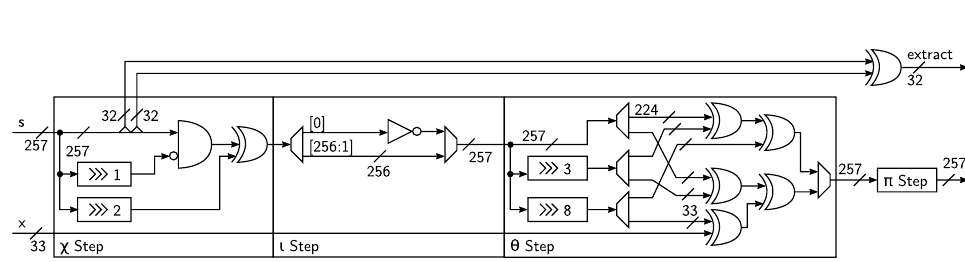
Figure 3: Subterranean duplex combinatorial